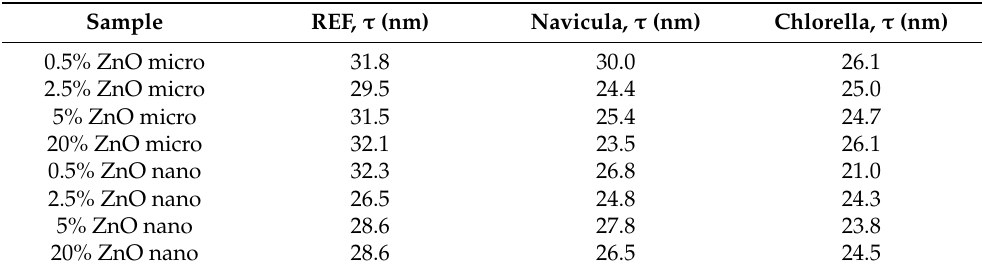
Table 2. Mean crystallite values calculated using Scherrer’s equation before and after Navicula and Chlorella